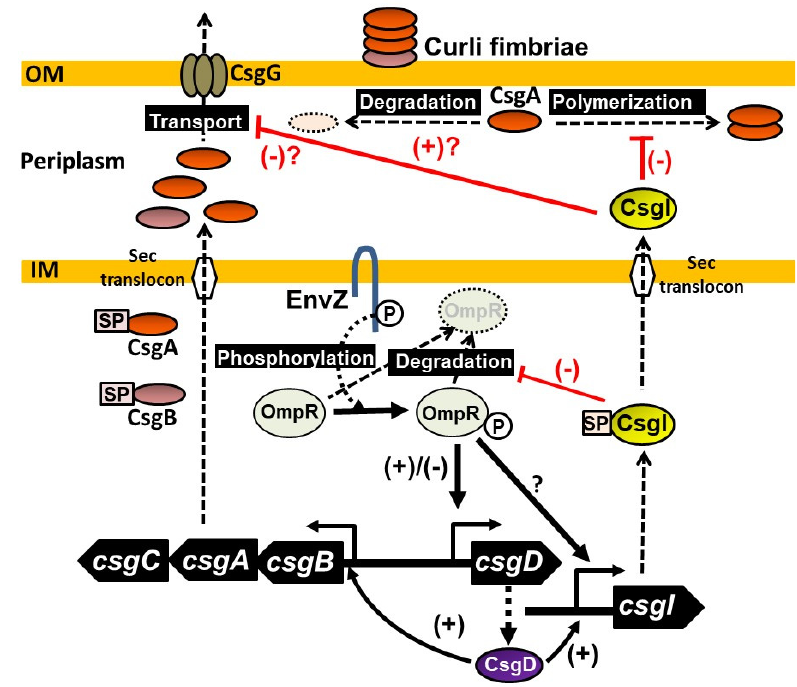
Figure 9. Schematic model of curli synthesis mechanisms and YccT inhibitory action.